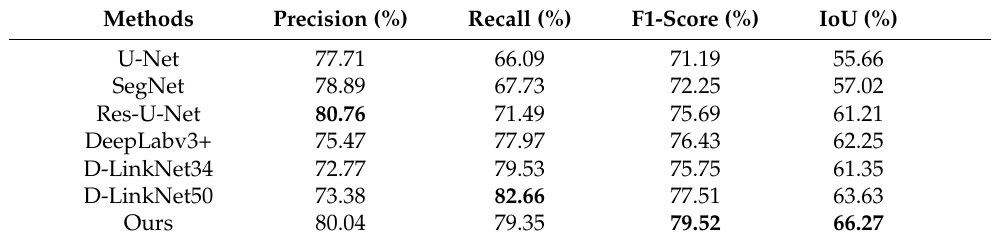
Table 1. The performance comparison of related methods on the Massachusetts test dataset.